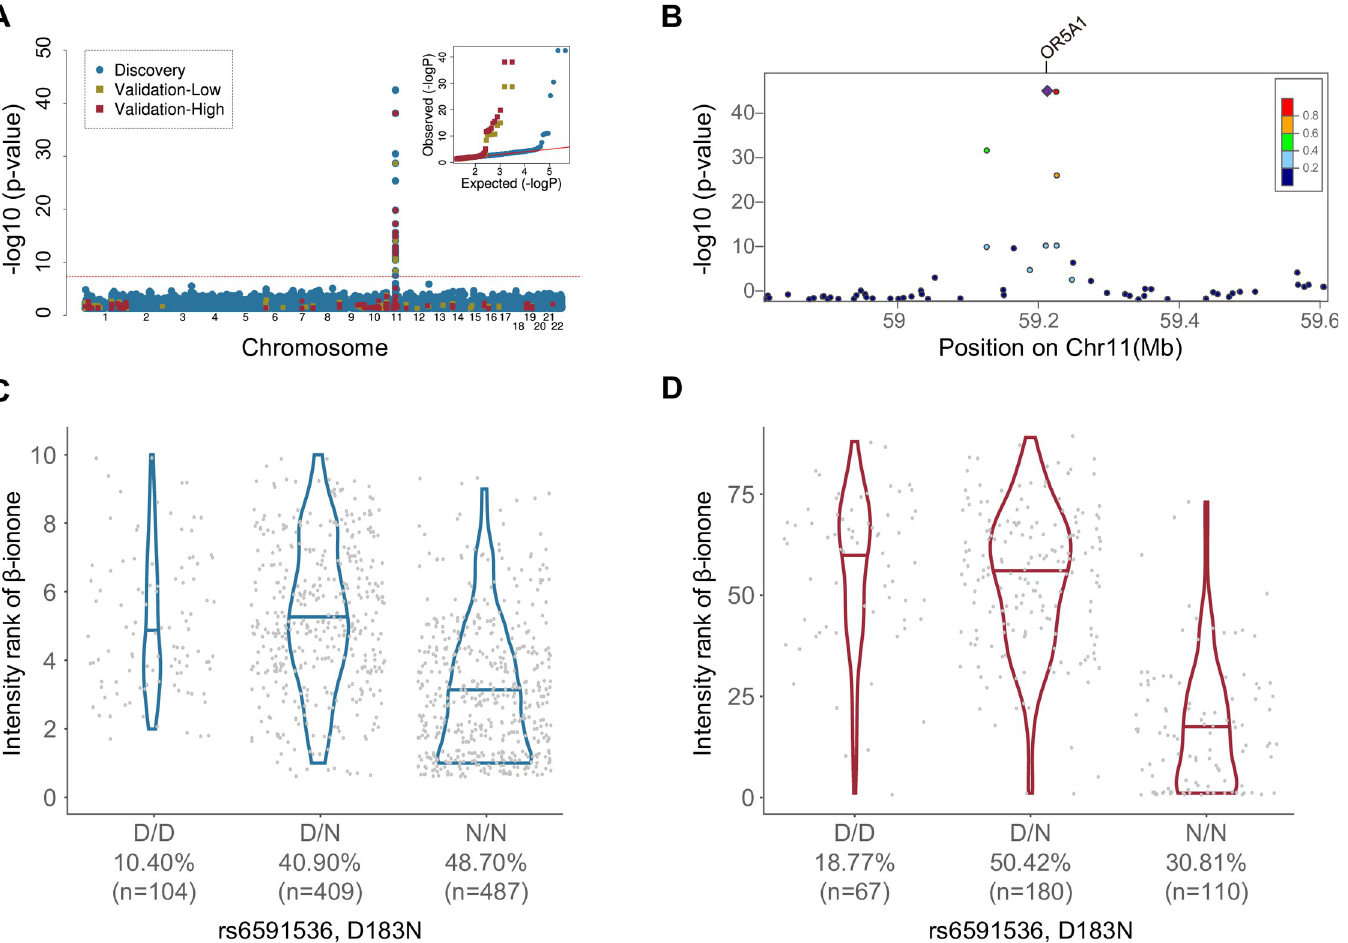
Fig 5. β -ionone perception is associated with variation in rs6591536 (OR5A1) in both cohorts , as shown by A) a Manhattan Plot of associations with the discovery study in blue and validation study in red (high concentration) and yellow (low concentration). The red line indicates the threshold for genome-wide significance (p < 5x10 - 8 ). Inset: QQ plots from the discovery (blue) and validation ([high] = red, [low] = yellow) cohorts (Genomic Lambda: discovery study = 1.00; validation study = 0.94) show appropriate control for inflation due to population structure. B) Regional plot of discovery study associations indicating both the significance level and the recombination rate at the OR5A1 LD-band. The previously discovered D183N variant (rs6591536; OR5A1) also changes perceived intensity of β -ionone in our populations: C) discovery cohort, D) validation cohort (high concentration). The x-axis is ordered left-to-right for increasing number of variant alleles, with population frequency indicated below the